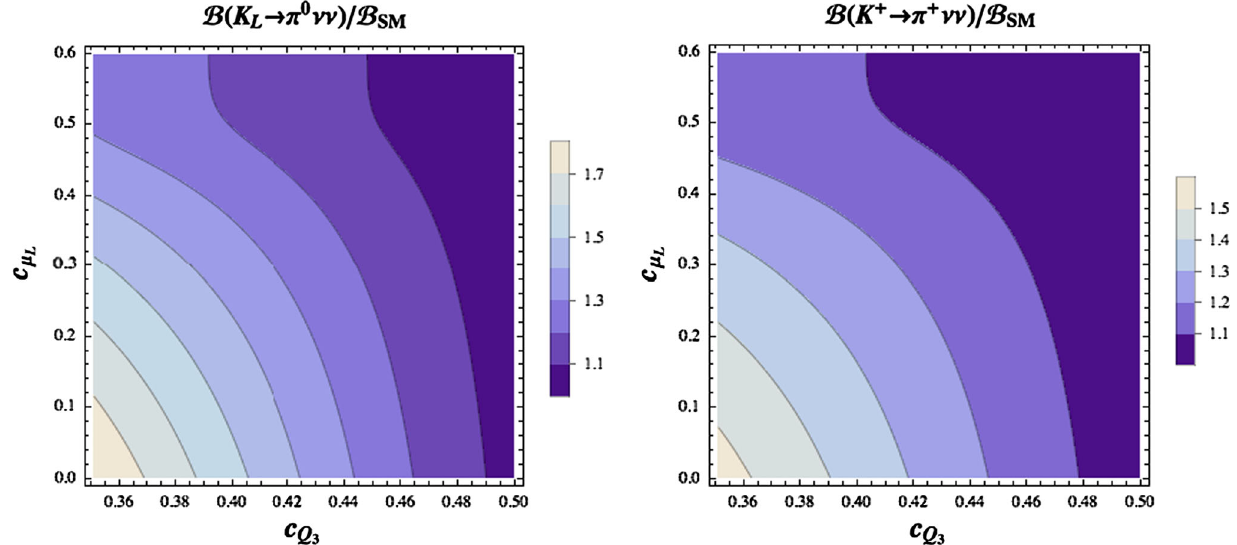
= 0 . 4 and c = 0 . 6 are fixed for the e L L